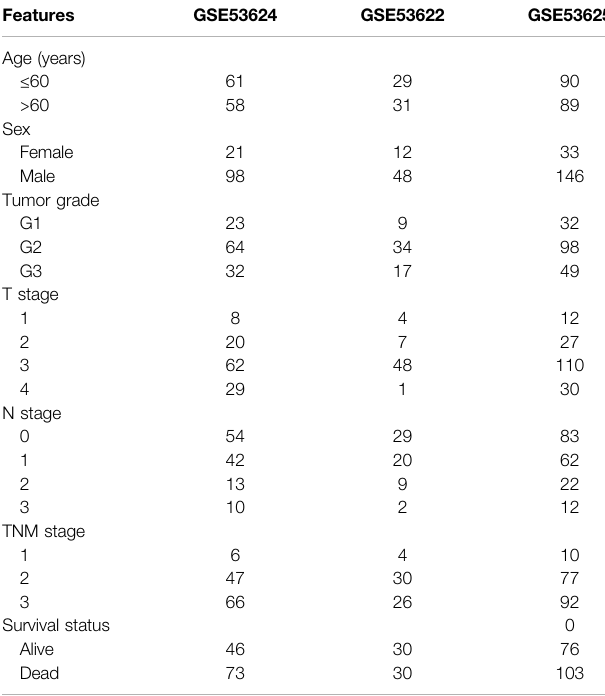
TABLE 1 | Clinical features of the ESCC patients from